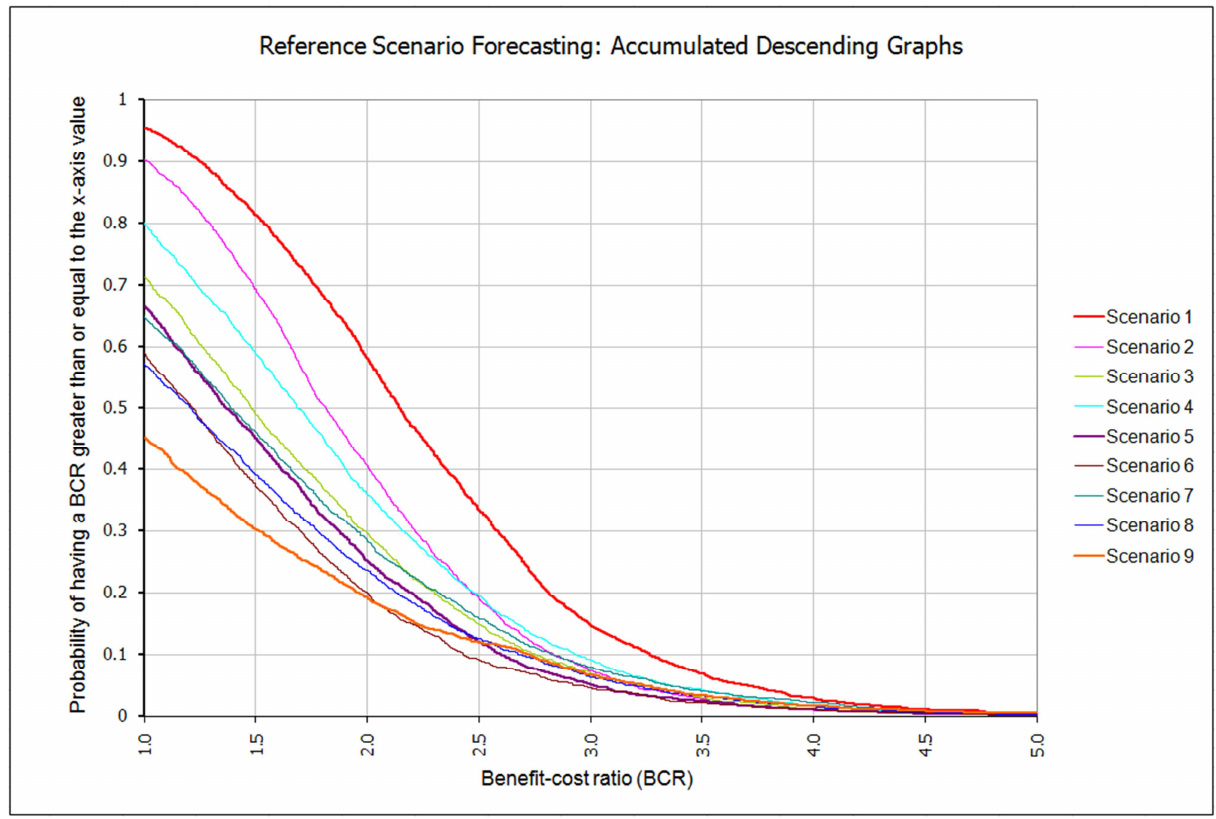
Figure 6. Resulting accumulated descending graphs (ADGs) from Reference Scenario Forecasting: the y- axis values for iBCR = 1.0 indicate the certainty levels of the scenarios The main output from the RSF is that none of the scenarios produces an ADG with 100% probability of achieving a BCR above 1.00. Scenario 1 returns a 95% certainty level that the Nuuk 2200 meter alternative is feasible whereas scenario 9 returns a 45% certainty level.